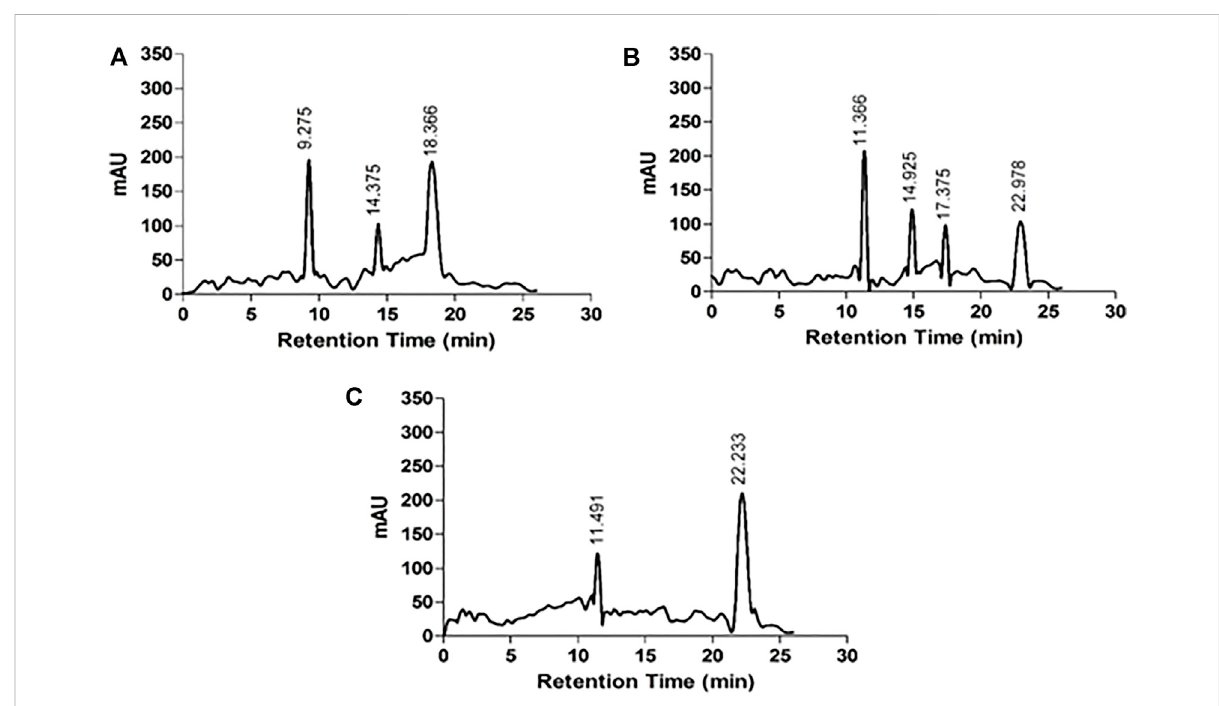
FIGURE 6 HPLC chromatograms of acid hydrolysates (A) native HSA (B) 4-Cl-OPD modi fi ed HSA and (C) L -cysteinesul fi nic